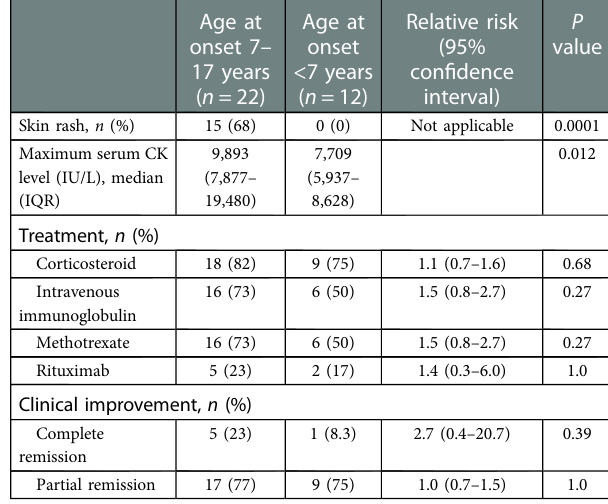
TABLE 2 Comparison of clinical characteristics according to age at onset among 34 pediatrics patients with anti-HMGCR myopathy. Age at onset 7